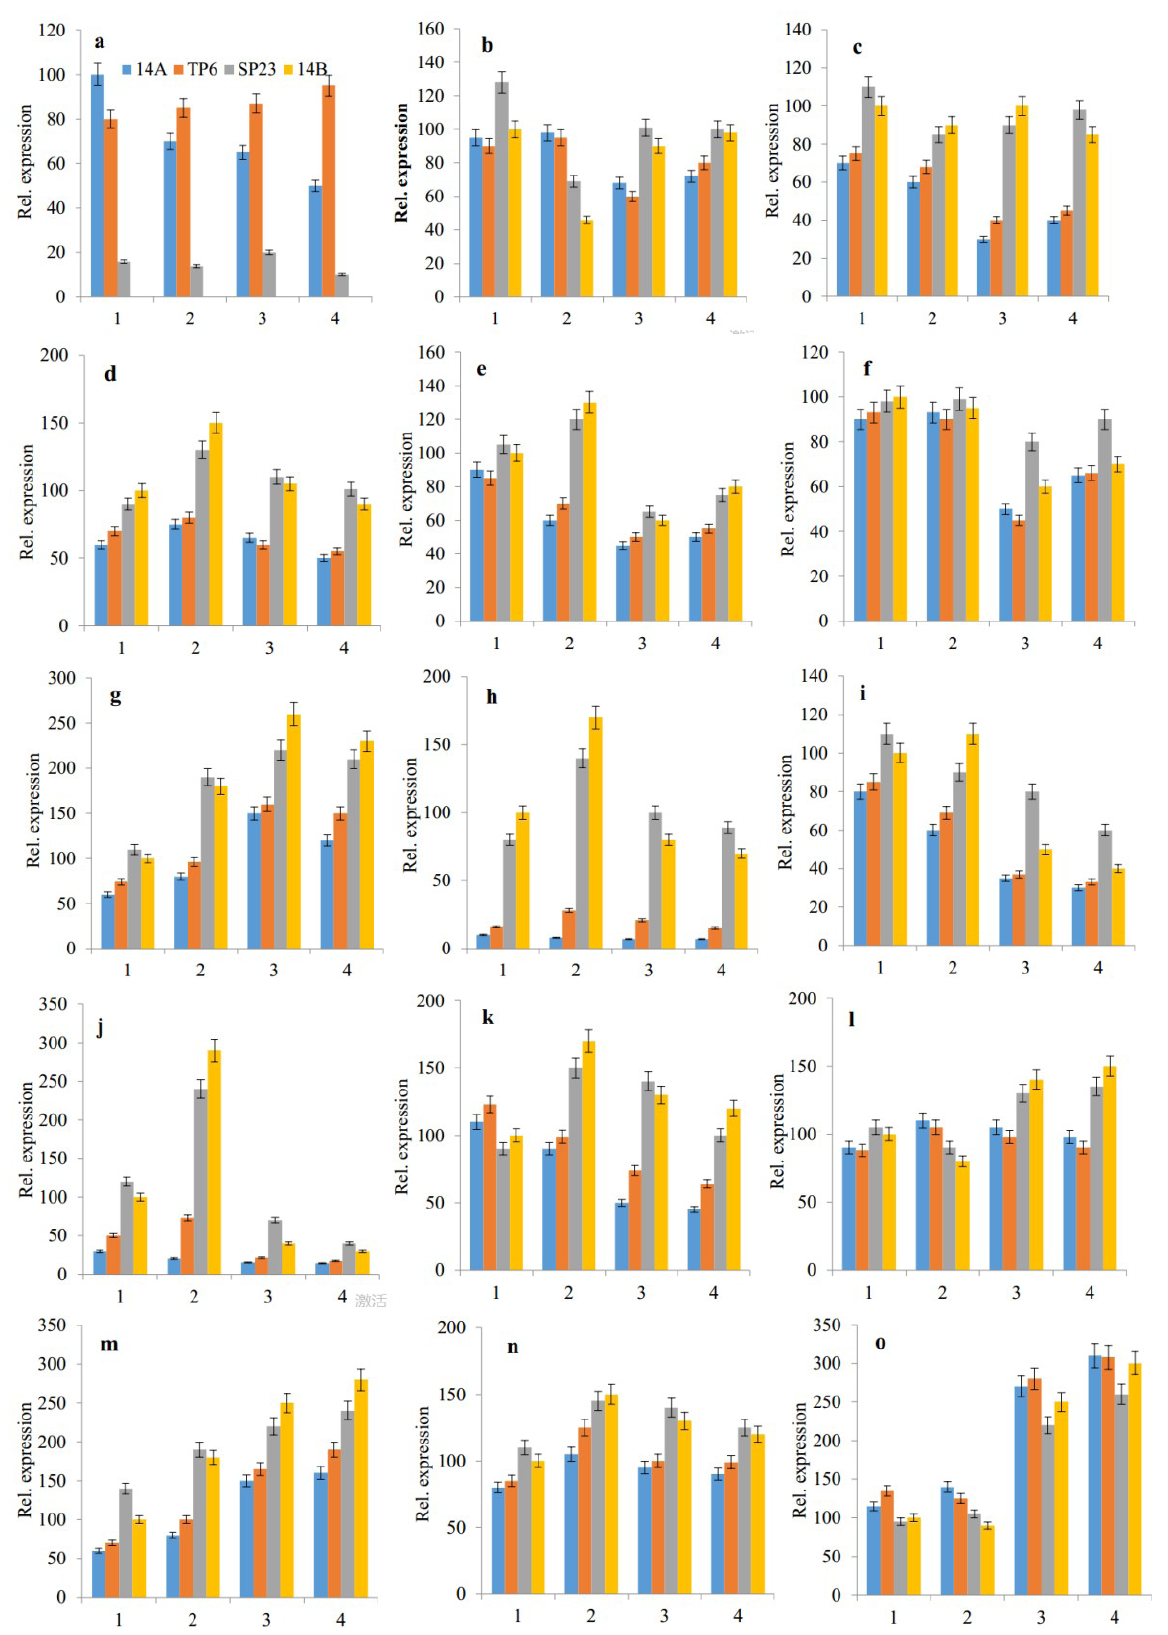
Figure 5 ‒ The qRT-PCR analysis of selected CMS-related gene and energy metabolism related genes in CMS-14A, TP6, SP23, and ML-14B. 1: the spore cell division stage; 2: pollen mother cell meiosis stage; 3: mononuclear microspores; 4: mature pollen stage. A: Unigene18482_All; B: Unigene13850_All; C: Unigene11869_All; D: CL5535.Contig2_All; E: CL9996.Contig2_All; F: Unigene2101_All; G: CL420.Contig2_All; H: CL5464.Contig1_All; I: Unigene28657_All; J: CL11399.Contig2_All; K: CL11665.Contig4_All; L: Unigene24327_All; M: CL367.Contig2_All; N: Unigene33404_All; O: